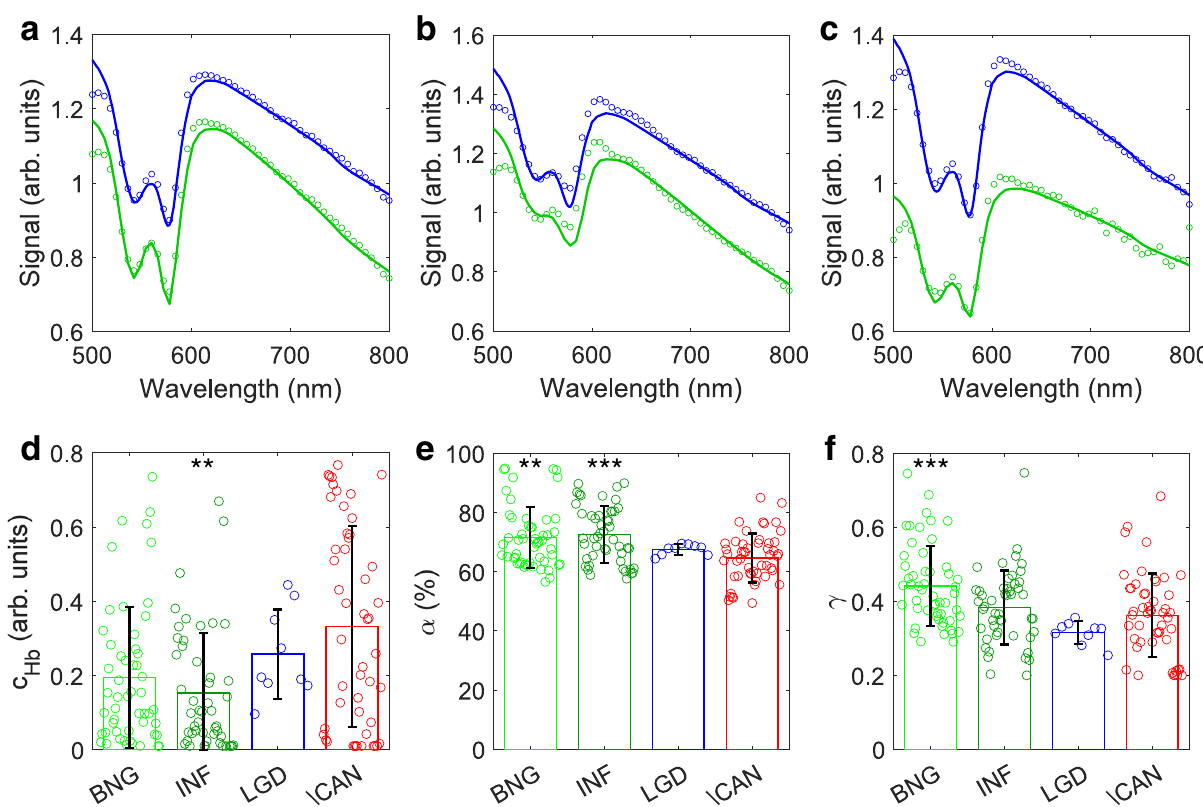
Fig.3|InvivospectracollectedduringroutineERCPclinicalproceduresinbile ducts and tissue physiological parameters extracted from DRS. Typical white light spectra of benign ( a ), in fl ammation ( b ), and high-grade dysplasia ( c ) sites collectedwithLSS-DRSprobe(circles)at120 µ m(blue)and240 µ m(green)source- detector separations and three-parameter fi ts (solid lines). Hemoglobin con- centration c Hb ( d ), oxygen saturation α ( e ), and scattering power γ ( f ) in the underlying connective tissue reconstructed from in vivo DRS data for all bile duct sites. The bar heights represent the mean values for each category and the error